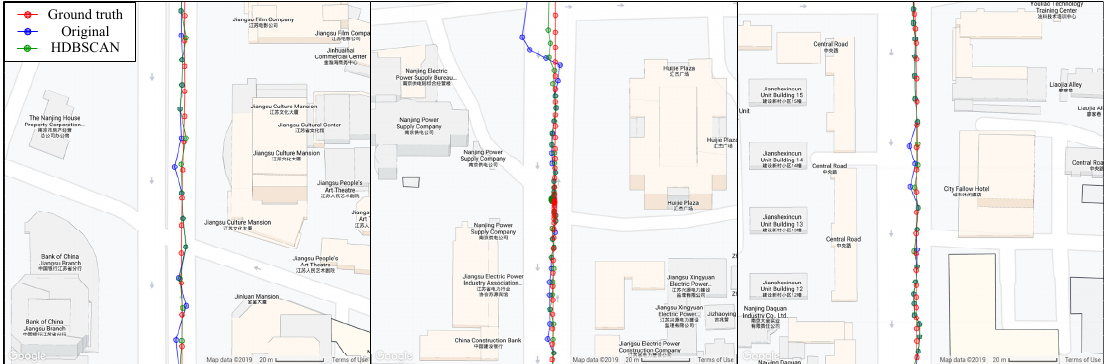
Figure 11. The positioning accuracy is greatly improved at the epochs with enough normal observations after anomaly exclusion.